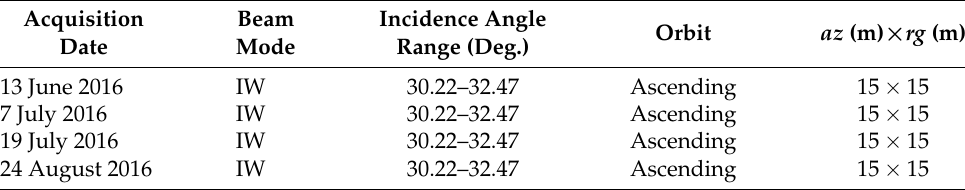
Table 1. Specification for Sentinel-1 data acquired for the Canadian test